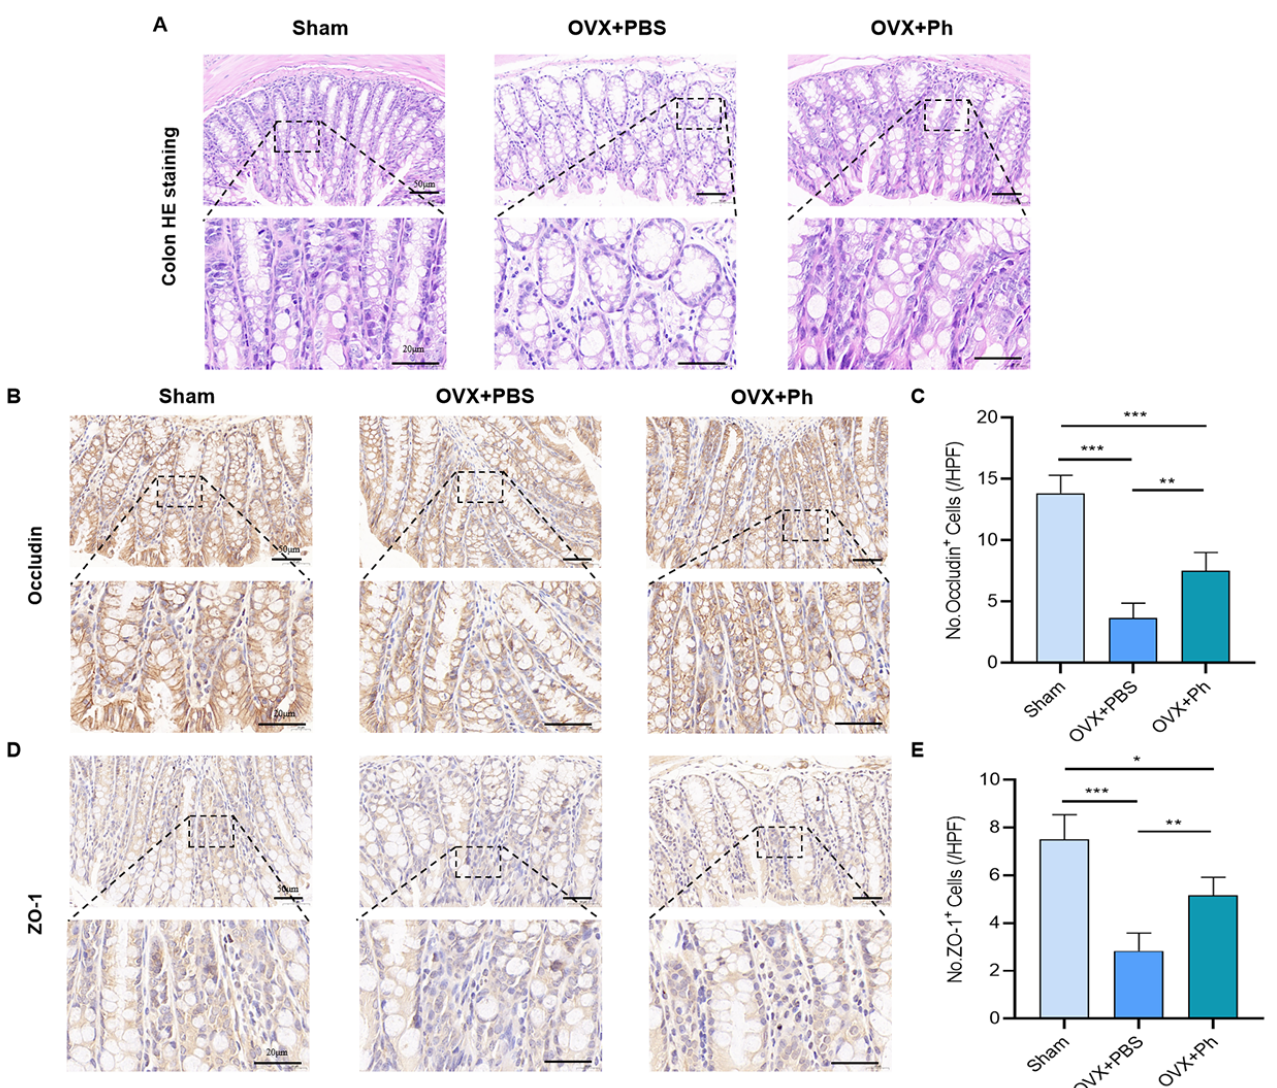
Figure 5. The perfusion of Ph reversed the OVX-mediated intestinal mucosal barrier damage. ( A ) The H&E staining of colon tissues. The scale bars represented as 50 μm and 20 μm; ( B ) Occludin stained the sections of colon tissues. Scale bars represented as 50 μm and 20 μm; ( C ) No. Occludin + cells; ( D ) The ZO-1 stained the sections of colon tissues. The scale bars represented as 50 μm and 20 μm; ( E ) No. ZO-1 + cells. * p < 0.05, ** p < 0.01, and *** p < 0.001 compared with comparable group.